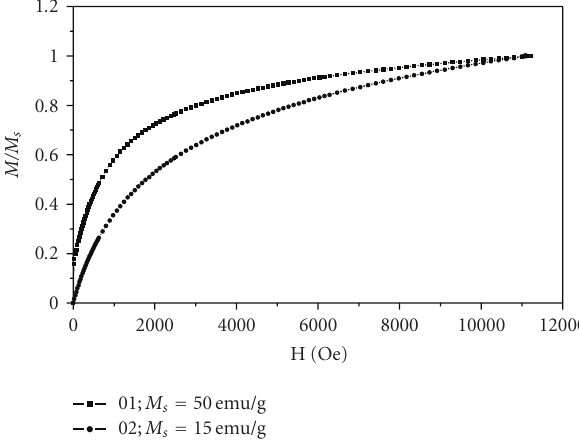
Figure 6: M¨ossbauer spectra (at 80K) of the two as-synthesized nanopowder samples; at the right side, the probability distributions of the hyperfine field are also displayed.